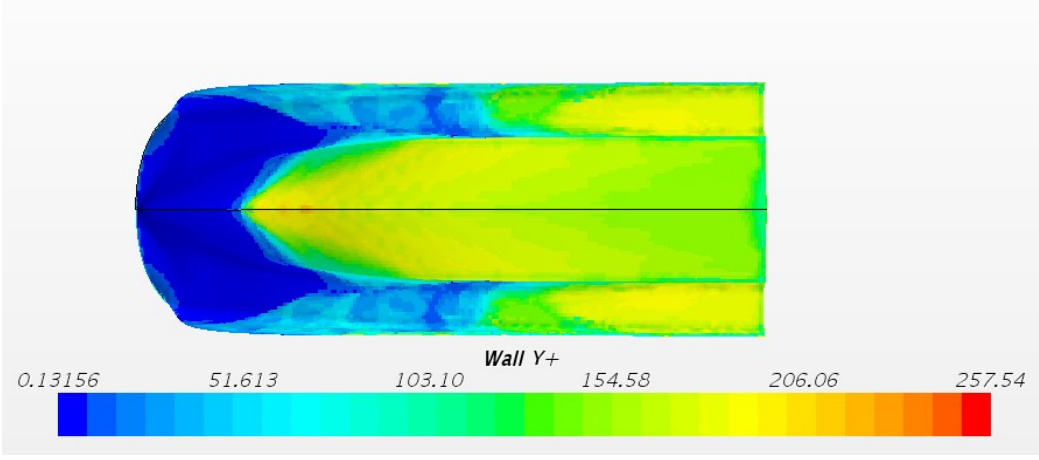
Figure 8. Wall y+ visualization on the hull at Fr Δ = 4.72.